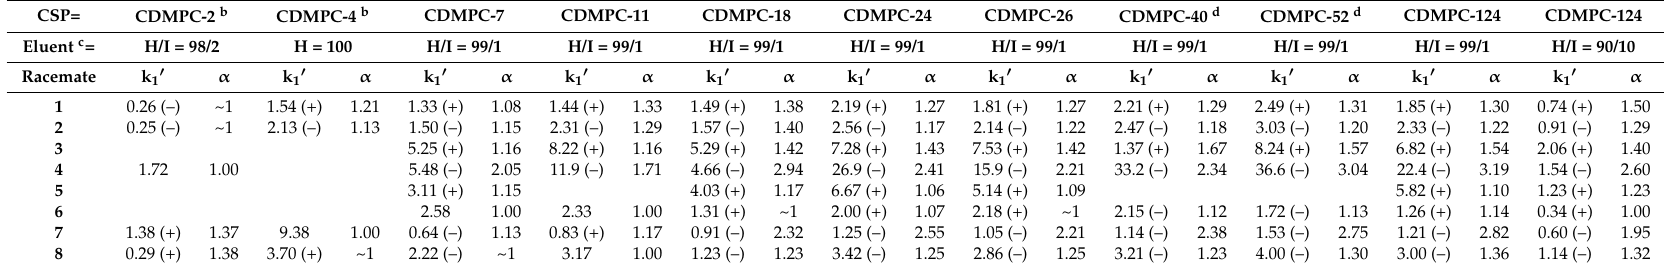
Table 3. HPLC separation of racemates 1 – 8 on the CSPs prepared from 10 CDMPCs shown in Table 2 a